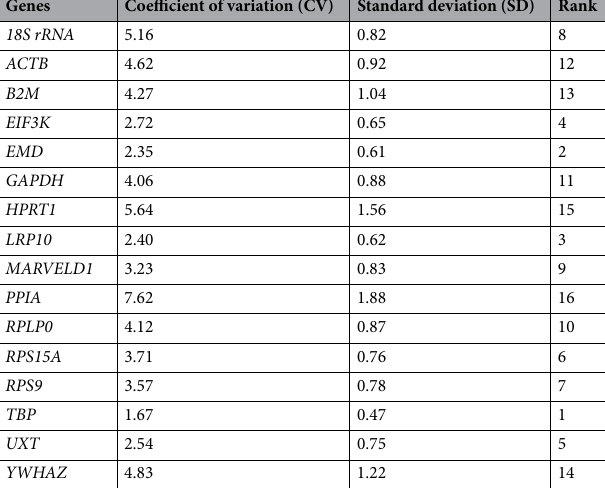
Table 2. Expression stability of candidate reference genes in bovine SMSCs after induction of differentiation estimated by Bestkeeper algorithm.